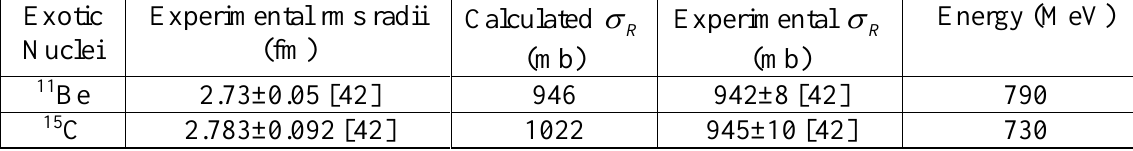
Table 1: Calculated reaction cross sections for 11 Be and 15 C exotic